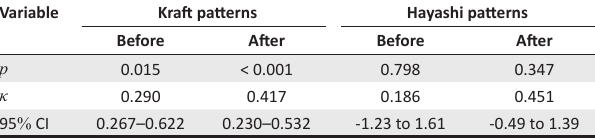
TABLE 6: Fleiss’ κ calculations before and after imputation. Variable Hayashi patterns